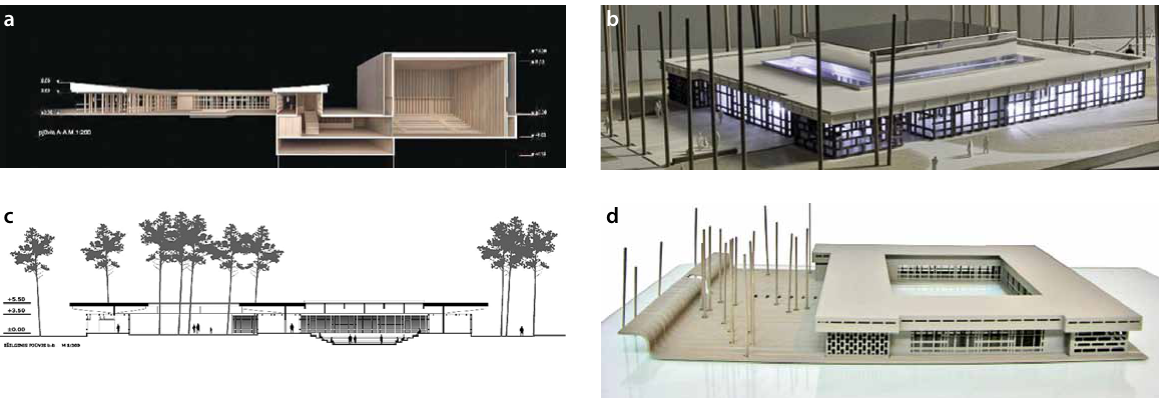
Fig. 7. Summer reading hall of the national Martynas Mažvydas library, Vytauto g. 72, architect a. Čepys, and public garden with a sculptural decor ‘Girl’ or ‘a monument to commemorate the pioneer camp’s tragedy’ (u. k. 15281,Dr 1299), sculptress